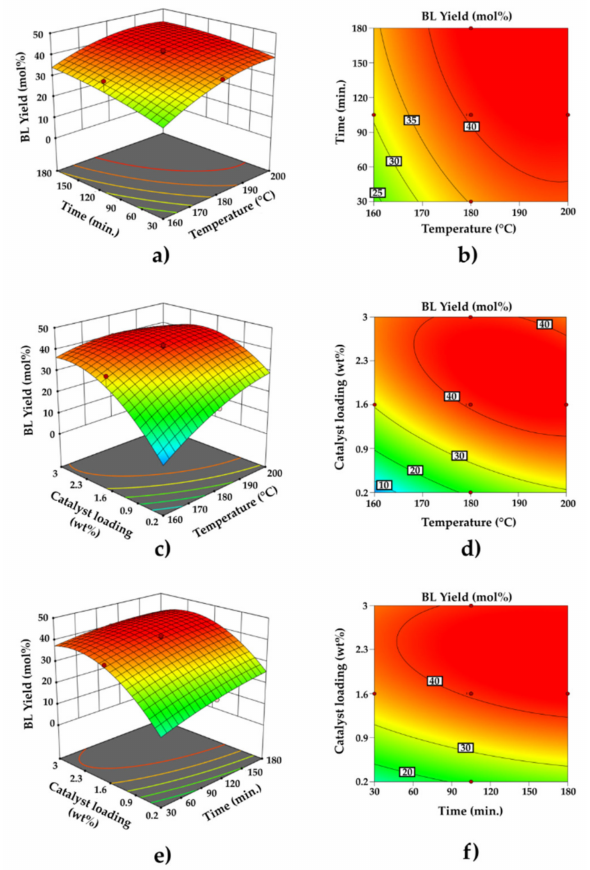
Figure 8. Three-dimensional (3D) response surfaces and two-dimensional (2D) contour plots: e ff ect of temperature, reaction time, and acid concentration on BL molar yield. ( a , b ) catalyst loading was kept constant at 1.6 wt%; ( c , d ) reaction time was kept constant at 105 min; ( e , f ) temperature was kept constant at 180 ◦